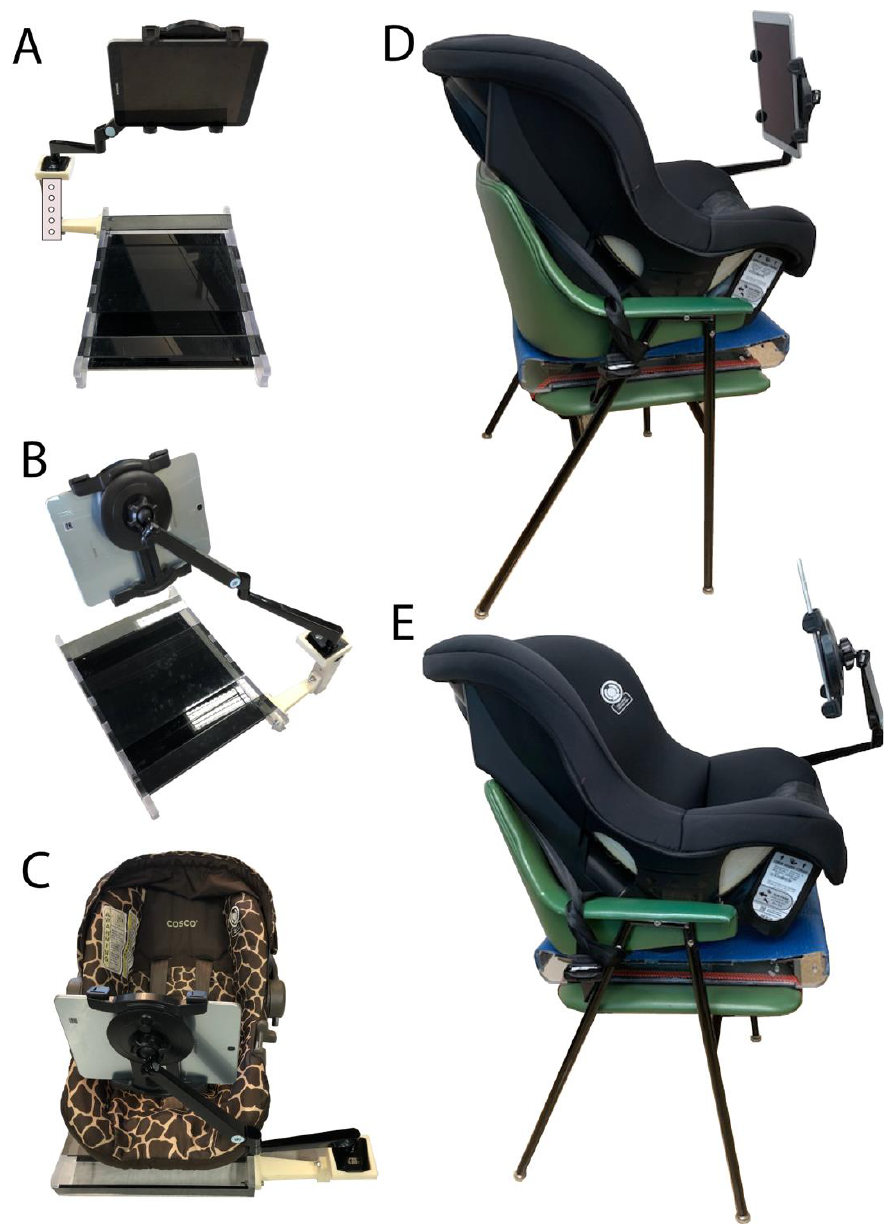
Figure 4. Car chair support and tablet holder system. ( A , B ): Rear and frontal view of the mechanical frame attached to the acrylic base that allows to hold and accommodate a tablet in front of the infant seat on the car chair. ( C ): Car seat for infants of 4 – 22 pounds. ( D , E ): Lateral views of the same system support a larger car seat for infants of 22 – 40 pounds and a tablet while the system is placed on the top of a high chair. Note: the chairs used on this figure are examples of how we took advantage of combining such chairs and the COR system. In the text we provided suggestions on how to attach both components, however the use of chairs with the COR system is under your own risk.